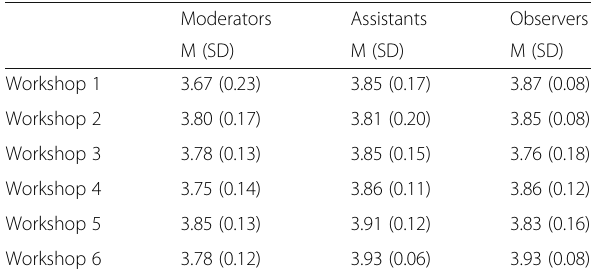
Table 3 Means and standard deviations of the fidelity index to the manual in the development of the workshops Moderators Assistants